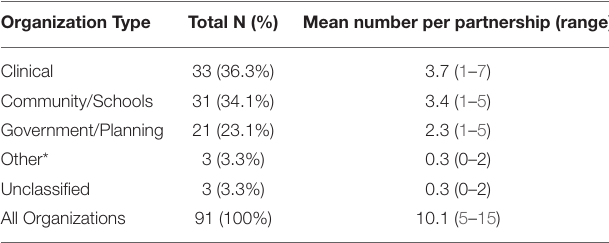
TABLE 1 | Representation of different types of organizations across the nine partnerships ( n = 91